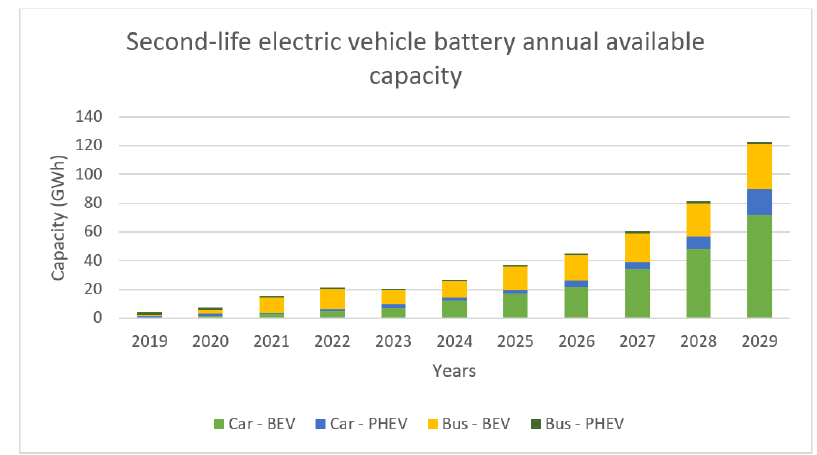
Figure 1. Annual battery capacity for the 2nd life battery [14]. Table 4. Markets for 2nd life batteries